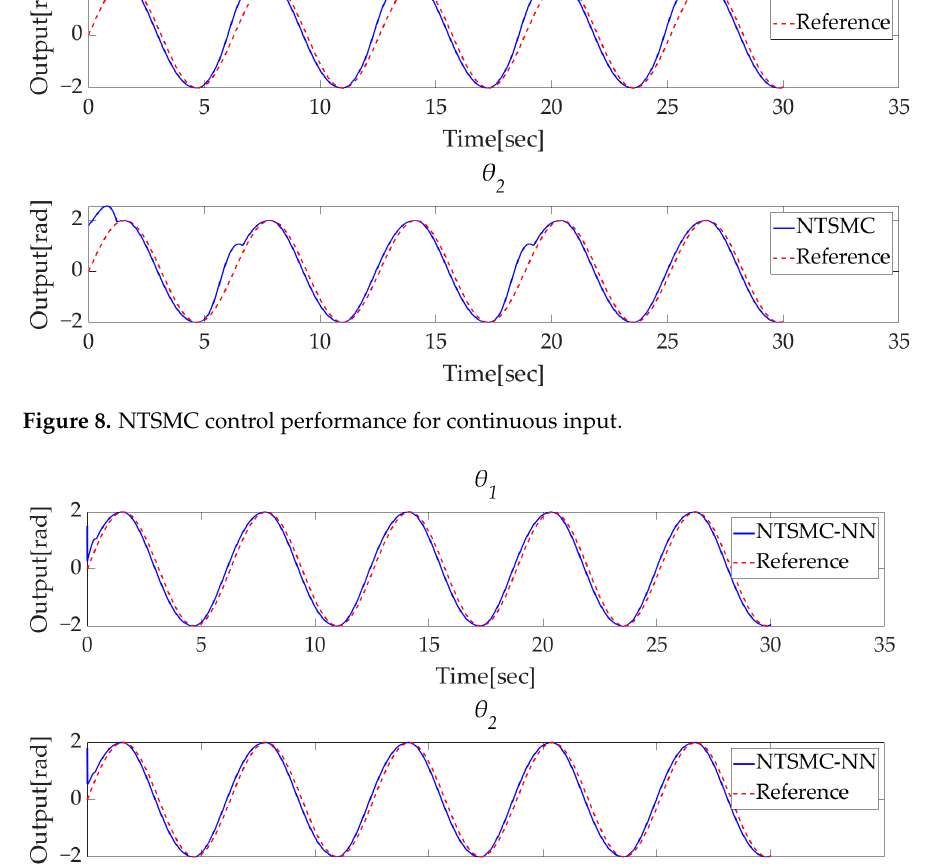
Figure 11. Proposed controller performance for continuous input. Figures 12 and 13 are compared for control input performance. As shown in Figures 12 and 13b–d, the controller is improved, it generates a greater control force than the NTSMC. However, as shown in Figures 12 and 13b, cha tt ering increased more than NTSMC, and as shown in Figure 13c, the control performance was more improved, but the previous robust term caused larger cha tt ering. As shown in Figures 12 and 13d, the proposed controller can generate a control input suitable for the situation, and the control input is removed when it is close to the steady state due to the reverse saturation function, and cha tt ering is improved.